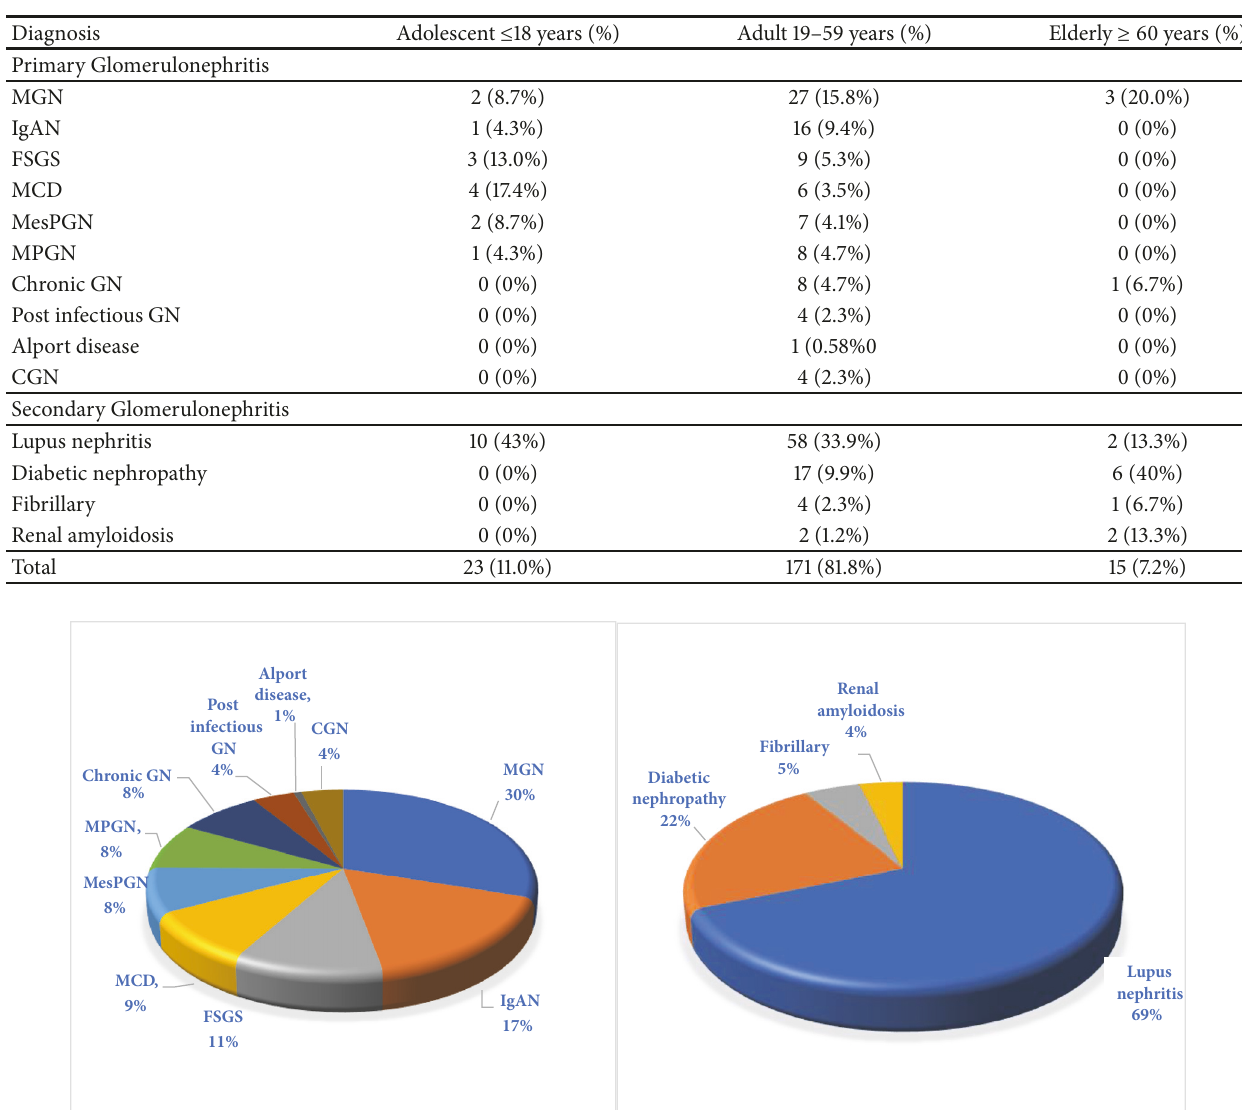
Table 3: Distribution of glomerular diseases based on patients’ age.